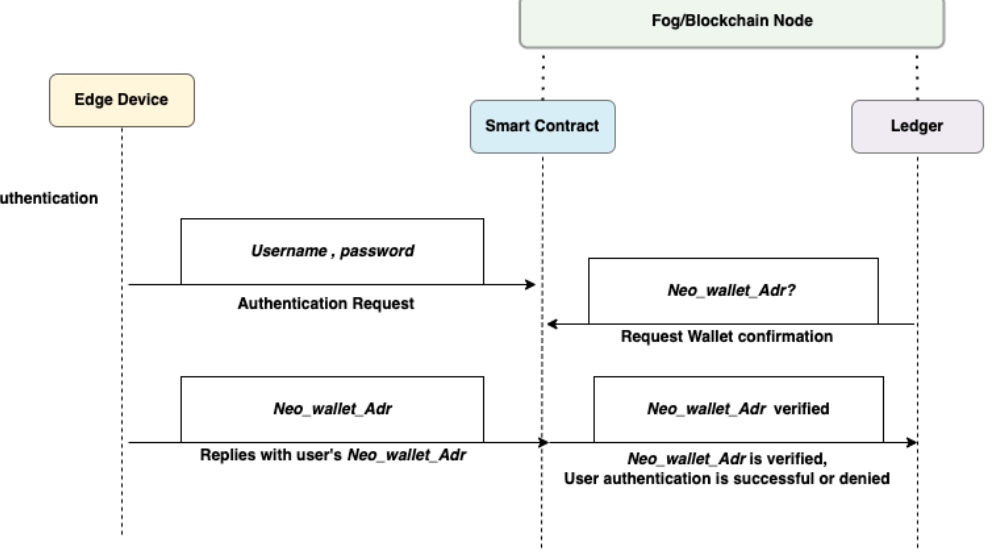
Figure 4. Flow diagram for User Authentication.